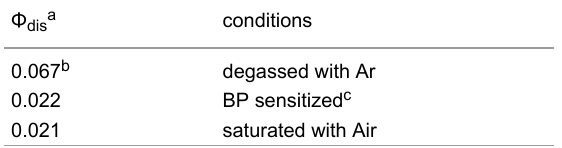
Table 2: Photolysis of 1,4-HNA diethyl phosphate ( 14a ) in the pres- ence and absence of O 2 and benzophenone in 1% aq MeCN. Φ disa conditions 0.067 b degassed with Ar 0.022 BP sensitized c